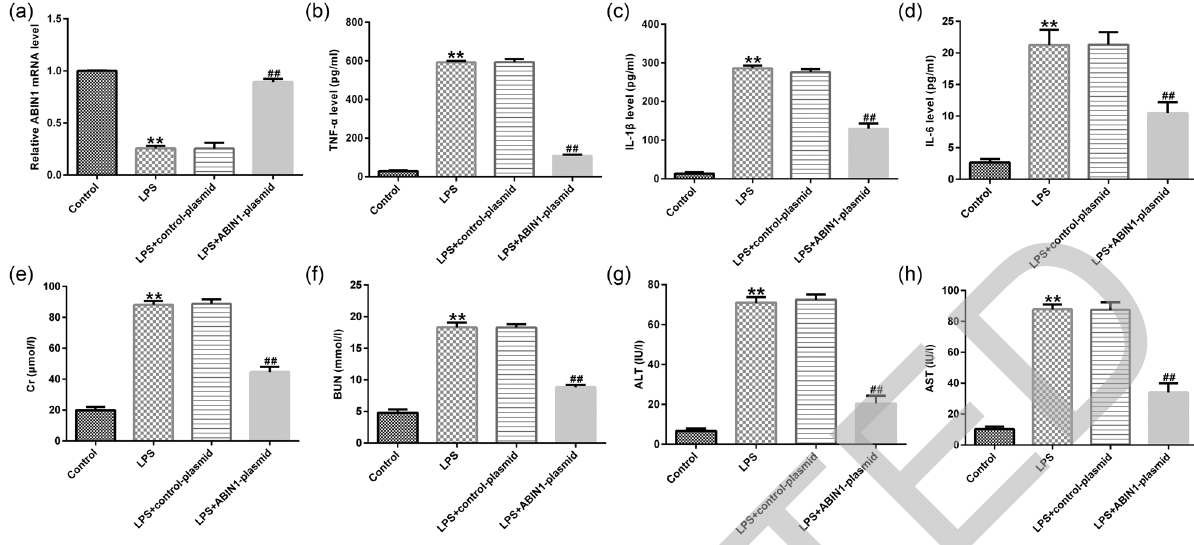
Figure 4: LPS a ff ected the in fl ammatory factors ’ secretion and liver damage. ( a ) qRT - PCR analysis was carried out to evaluate ABIN1 expression. Secretion of ( b ) TNF - α , ( c ) IL - 1 β , and ( d ) IL - 6 in serum were veri fi ed using ELISA assay in control and LPS groups. ( e ) Serum Cr, ( f ) BUN, ( g ) ALT, and ( h ) AST levels were determined in control and LPS groups. ** p < 0.01 vs control, and ## p < 0.01 vs LPS + control -